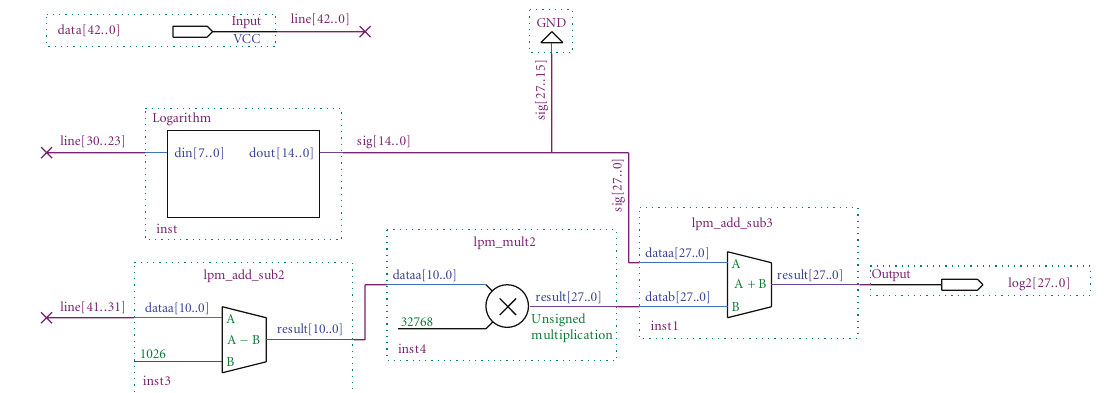
Figure 18: FPGA realization of logarithm function (log 2 function).